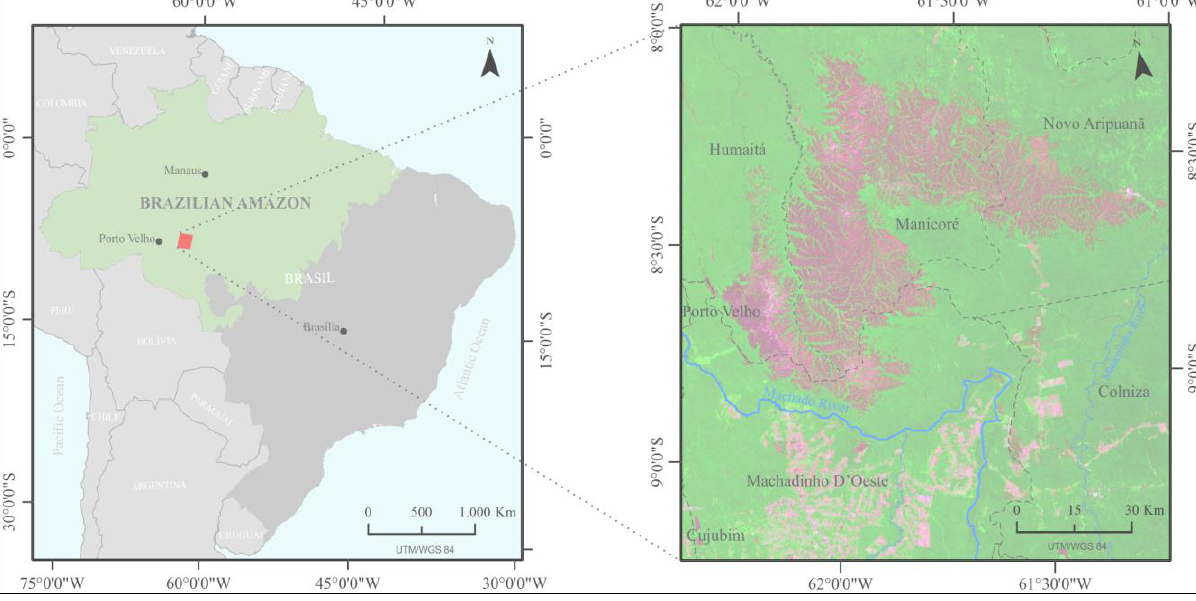
Figure 1. Study site location (red polygon) in the south of Brazilian Amazon (green polygon in the left map). In the right map, the municipal division of the study area on a clip image Landsat ETM+ (path/row-231/66, composition RGB-643) of August 28,